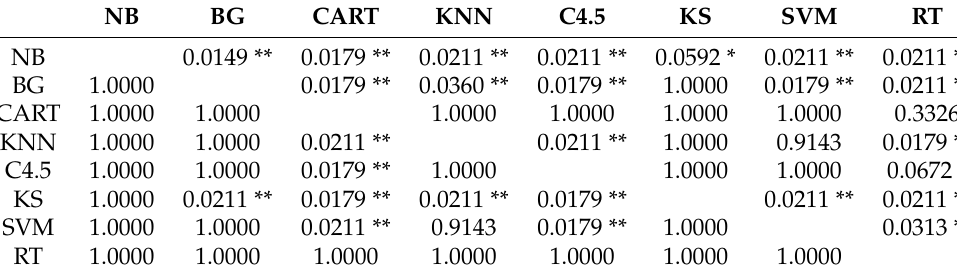
Table 12. Pairwise WSR test for AUROC of toddlers.